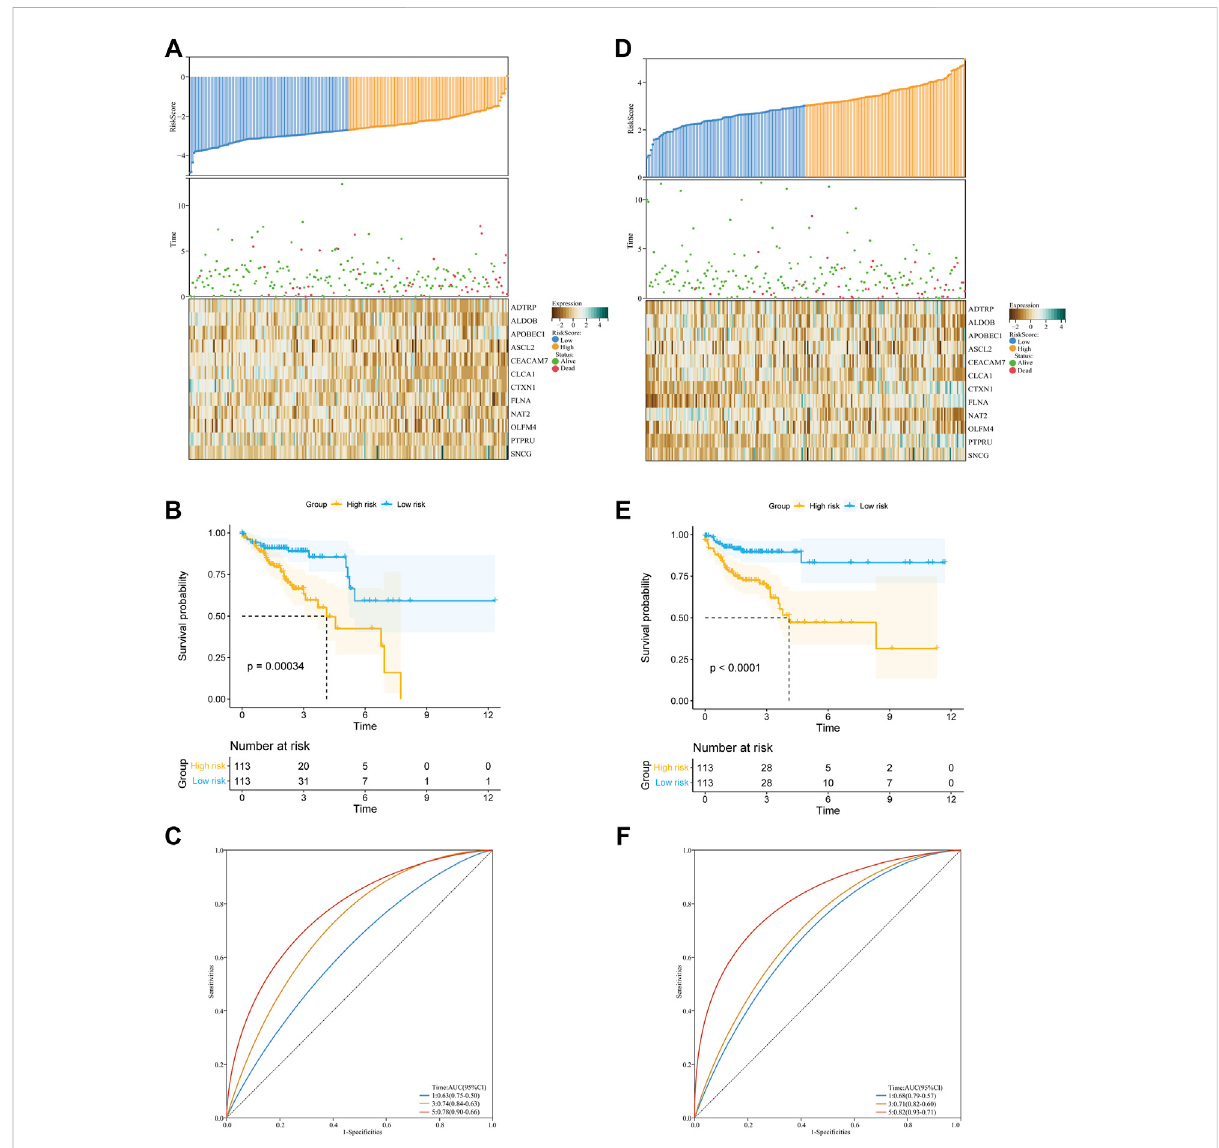
FIGURE 4 Construction and validation of the glycolysis- and lactate-related gene prognosticsignature. (A,D) Predictive ability of theprognostic signature in the training cohort (A) and validation cohort (D) . Distribution of the risk score (upper), survival time (middle), and heatmap of selected glycolysis- and lactate-related genes (below). (B,E) KM survival curves of OS for COAD patients between the training cohort (B) and validation cohort (E). (C,F) ROC curves for the 1-, 3-, and 5-year survival in the training cohort (C) and validation cohort (F)